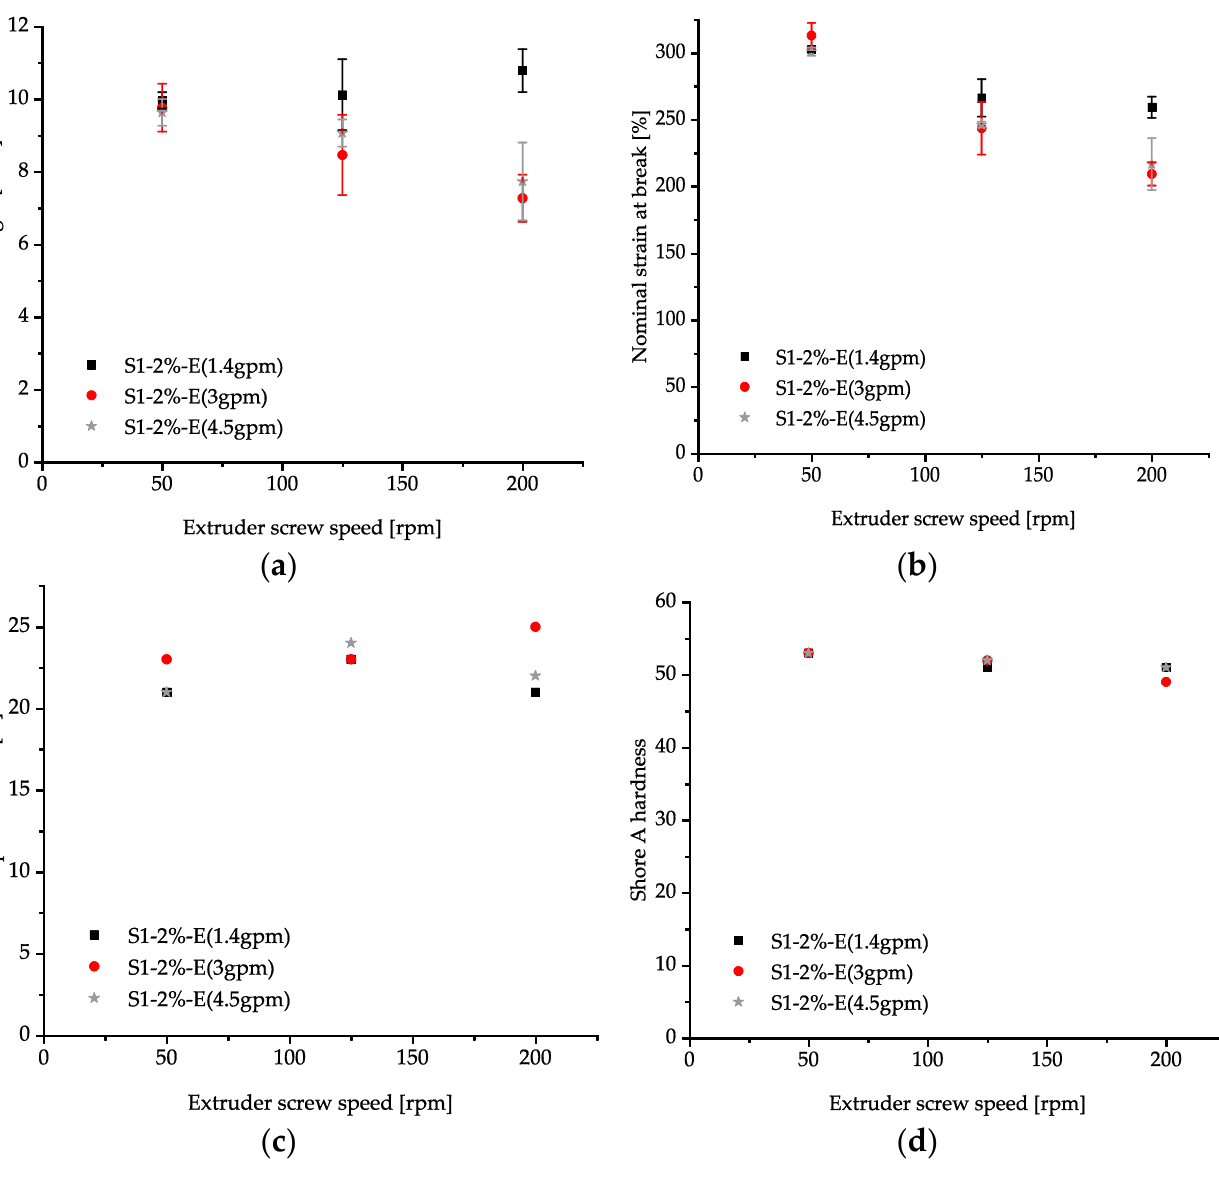
Figure 6. Tensile strength ( a ), nominal strain at break ( b ), shore A hardness ( c ), and compression set ( d ) of samples S1-2%-E as a function of screw speed and flow rate.